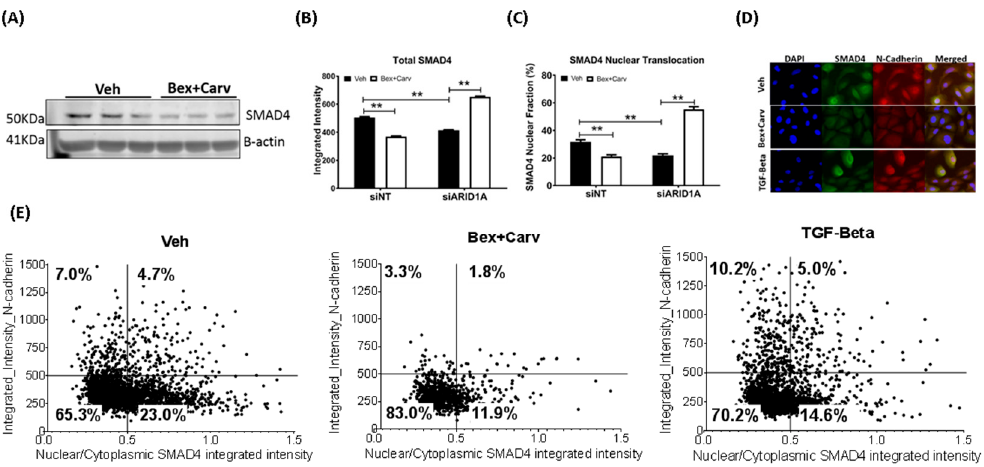
Figure 4. The impact of Bex+Carv or TGF- β treatment on SMAD4 protein expression and nuclear translocation and N-cadherin. ( A ) Western blot analysis for SMAD4 protein levels in HME-hTert cell extracts upon Vehicle vs. 100 nmole/L Bex + 1000 nmole/L Carv treatment for 48 h. ( B , C ) Quantification of SMAD4 protein expression ( B ) and its nuclear fraction ( C ) after siRNA-mediated silencing against Luciferase (siNT) or ARID1A (siARID1A) for 72 h and Veh vs Bex (100 nmole/L) + Carv (1000 nmole/L) treatment for 24 h. A minimum of 500 cells were analyzed individually using CellProfiler for the integrated intensity of SMAD4 in the nucleus and the cytoplasm. The results are expressed as mean ± SEM, ** p < 0.01 by One-way ANOVA, Tukey post-hoc test. ( D ) Representative images of cells treated with Veh or Bex+Carv for 3 days, or TGF- β for 1 day and immunostained for SMAD4 and N-Cadherin (20 x magnification). ( E ) Scatter plots of nuclear/cytoplasmic ratio of SMAD4 and N-cadherin levels in cells treated with Veh, 100 nmole/L Bex+ 1000 nmole/L Carv for 3 days, or 5 ng/mL TGF- β for 1 day.